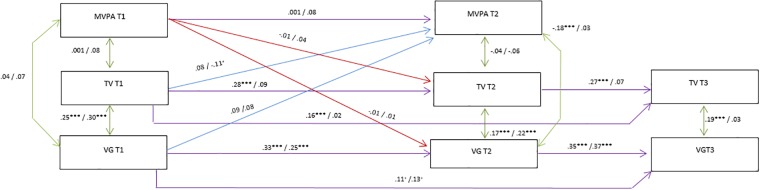
Associations between MVPA, TV and VG (Males n = 436, Females n = 374).Results from structural equation modelling. Estimates (standardized) are displayed as males/females. *** p<0.001, ** p<0.01, * p<0.05 (baseline confounders were omitted). The Adolescent Nutritional Assessment Longitudinal Study, 2010–2012, Brazil.